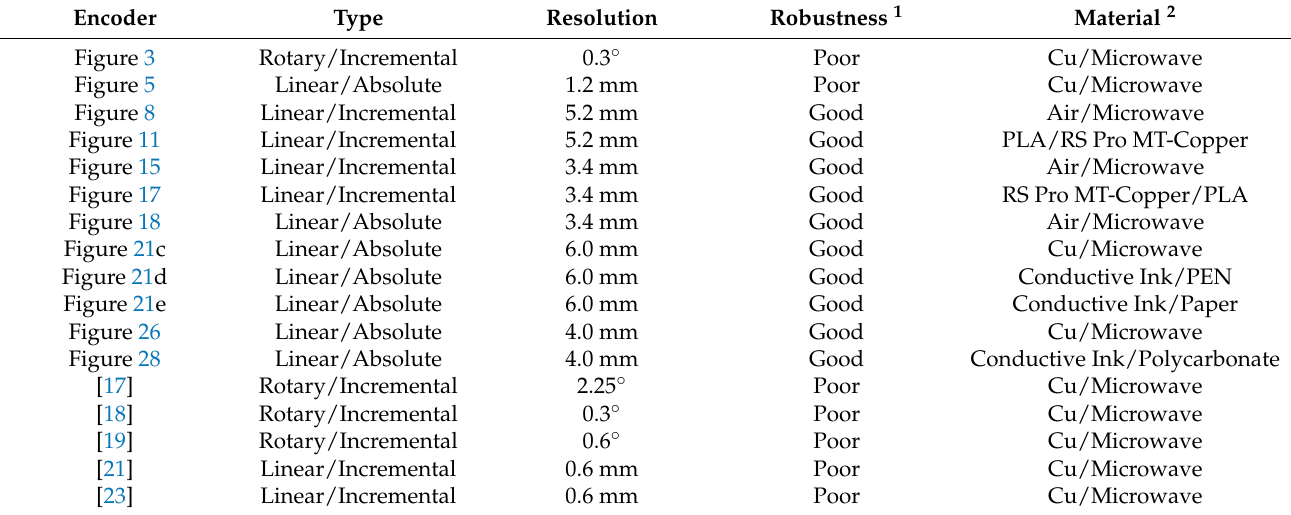
Table 1. Comparison of various electromagnetic